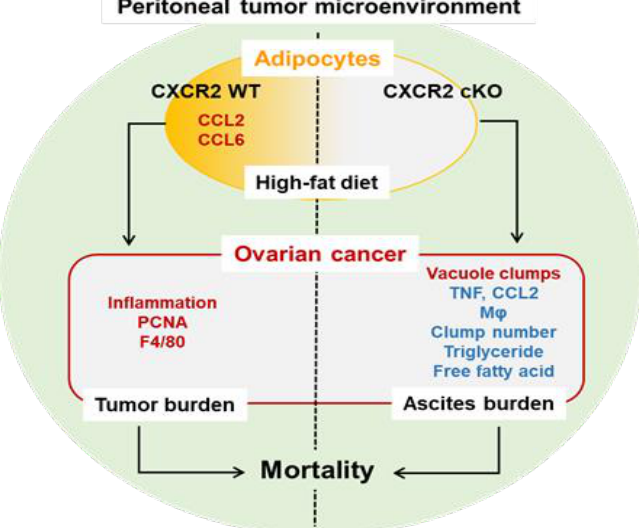
Figure 8. Schematic for HFD-induced obese effects of adipocyte-specific CXCR2 cKO on the peritoneal tumor microenvironment of OC. Adipose tissues express high levels of CCL2/6 in obese WT mice compared to those in obese cKO mice. Interestingly, obese CXCR2 WT and cKO mice appear to have greater tumor and ascites burdens, respectively. Compared to obese CXCR2 WT mice, the cKO mice had lower ascitic floating tumor burdens and tumor-attached Mo/M ϕ , less triglyceride, free fatty acid, CCL2, and TNF levels, but increased vacuole clumps in OC-induced ascites. Obese CXCR2 WT mice had more inflammatory areas and PCNA- and F4/80-positive cells in tumor tissues compared to obese cKO mice. HFD-induced obesity leads to a shorter survival time compared to lean mice, regardless of CXCR2 status in adipose tissues. Therefore, adipocyte-specific CXCR2 cKO is associated with ascites accumulation under obese conditions, instead of tumor burden as shown in obese CXCR2 WT mice, most likely altering the peritoneal tumor microenvironment of OC. Red and blue letters indicate increases and decreases,